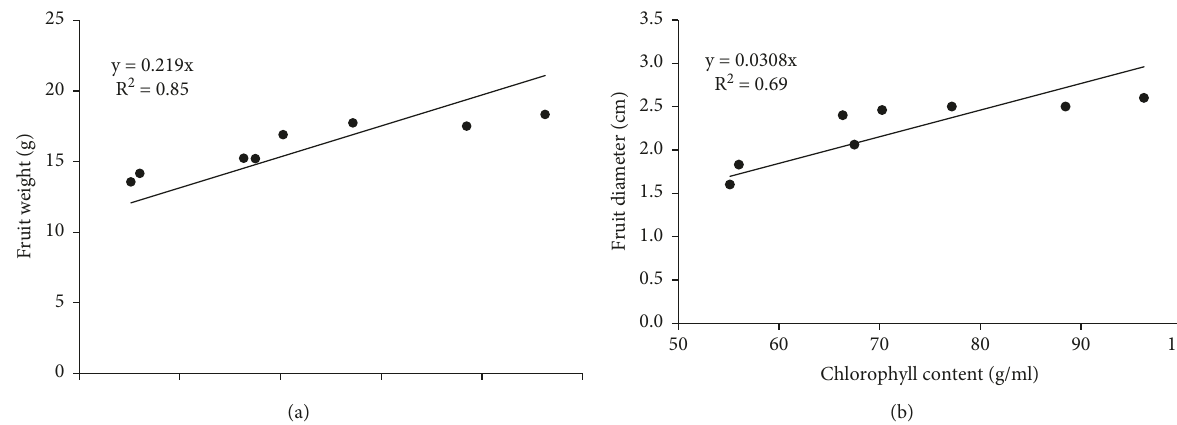
Figure 4: Correlation between chlorophyll contents (g/ml) (a) fruit weight (g) and (b) fruit diameter (cm) of strawberry cv. Chandler at P